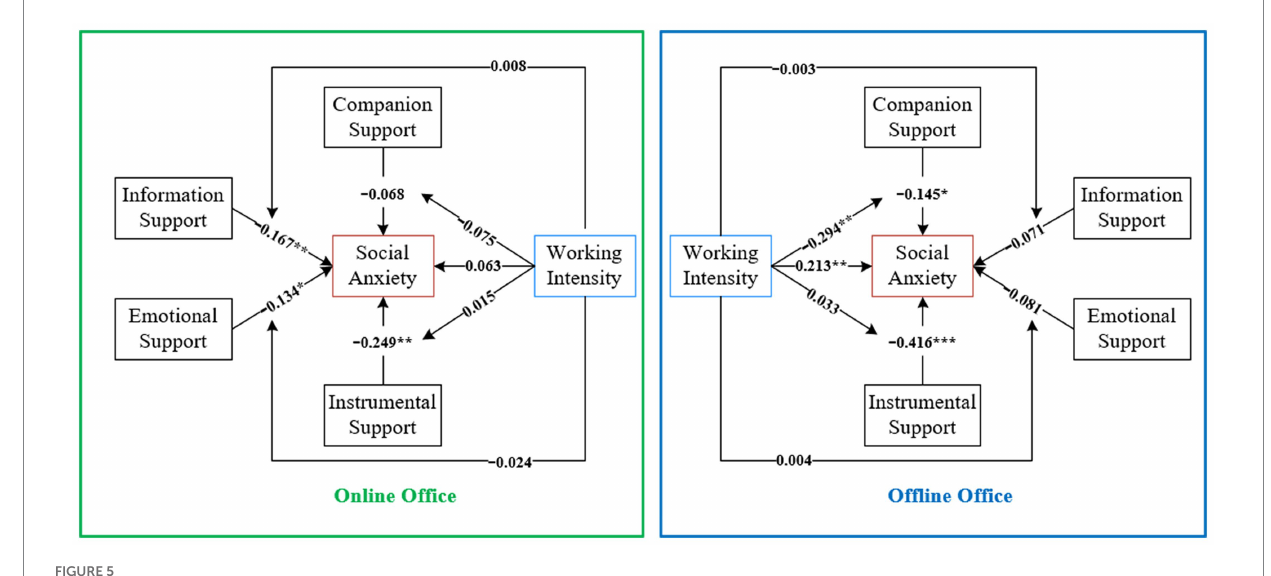
FIGURE 5 Differences of models under different office modes. * p < 0.01; ** p < 0.05; *** p <